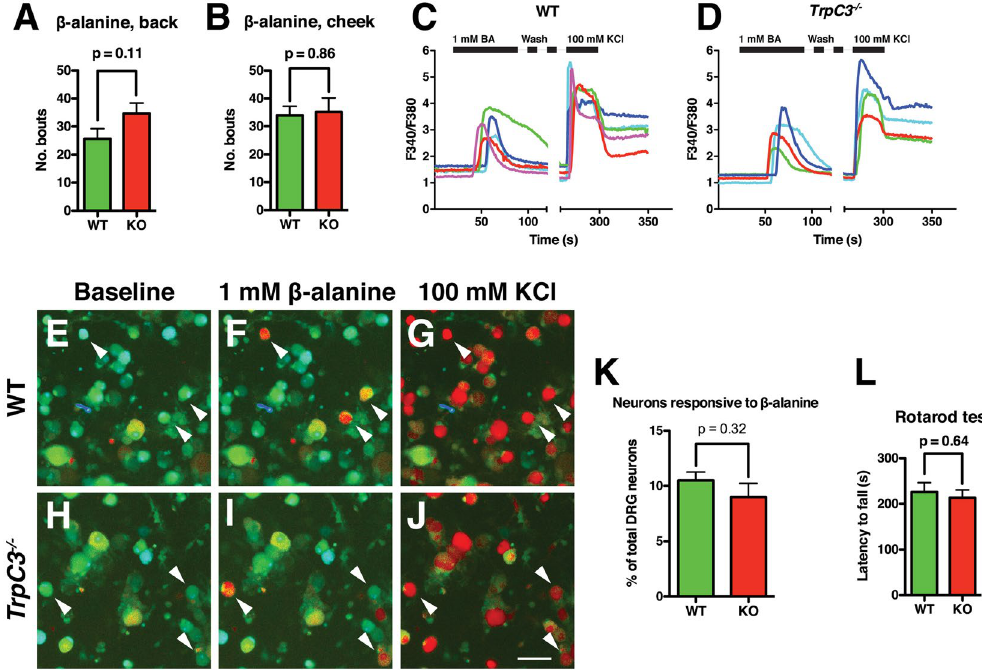
Figure 6. TRPC3 is not required for MRGPRD-evoked behavior or signaling at a cellular level. ( A,B ) Adult ( > 6 weeks old) TrpC3 KO and littermate WT control mice were scored for scratching behavior after β -alanine injection into the cheek and back. N = at least 7 mice per genotype for β -alanine back injection, at least 5 mice per genotype for β -alanine cheek injection. ( C , D ) Representative traces of calcium activity from littermate control and TrpC3 − / − null cultured DRG neurons. DRG neurons of both genotypes show normal responses to β -alanine, while activity in response to KCl demonstrates that the neurons are healthy and viable. ( E–J ) Representative images of DRG neurons from control ( E–G ) and TrpC3 − / − null ( H–J ) mice, with arrowheads indicating neurons that show responsiveness to both 1 mM β -alanine and 30 mM KCl. Percentages were pooled from results collected from 1,481 control and 990 TrpC3 KO DRG neurons from 6 animals per genotype. Scale bar = 50 μ m. ( K ) Bar graph comparing the percentage of all DRG neurons that showed a positive response to β -alanine between littermate control and TrpC3 − / − null cultured DRG neurons. No significant difference was seen (9.9 ± 0.8% in control DRG neurons vs. 9.3 ± 1.2% in TrpC3 KO DRG neurons; student t test). ( K ) Adult ( > 6 weeks old) TrpC3 KO and littermate WT control mice were scored for latency to fall off rotarod apparatus. N = 9 mice per